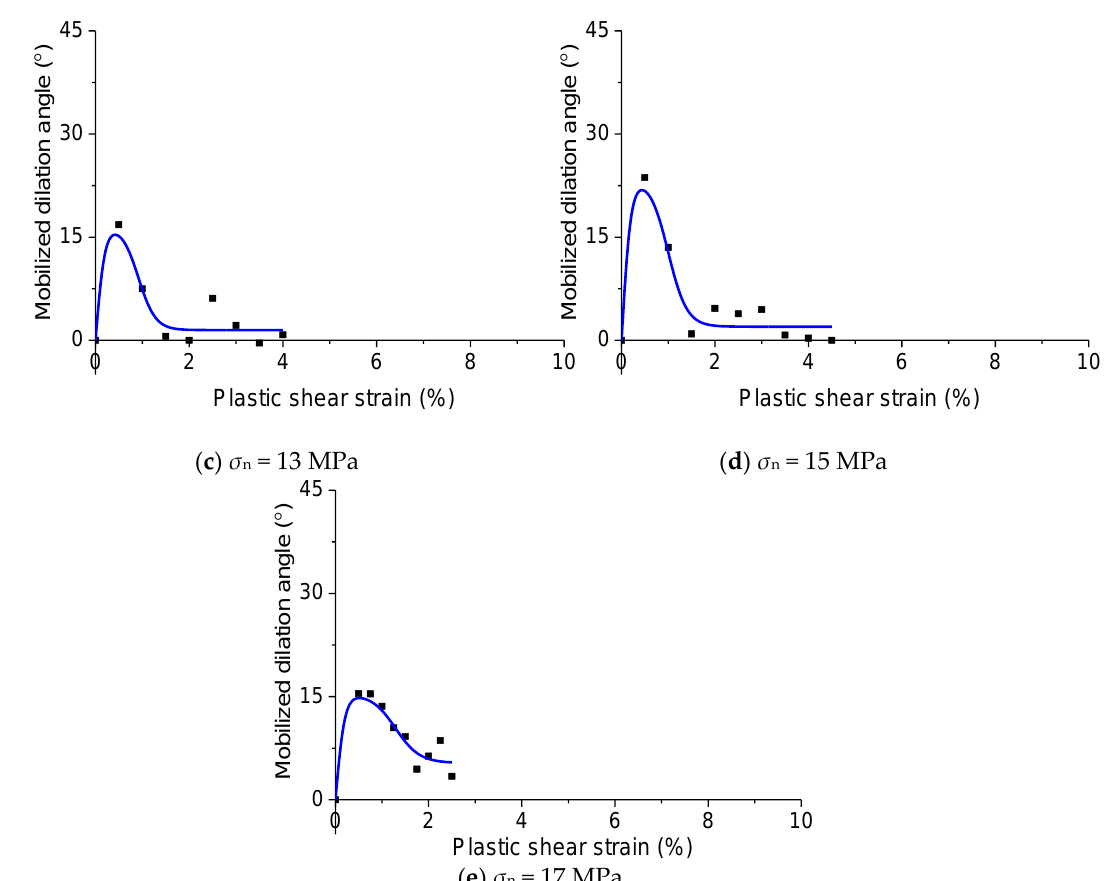
Figure 9. Mobilized dilation angle with increasing plastic shear strain under different normal stresses.